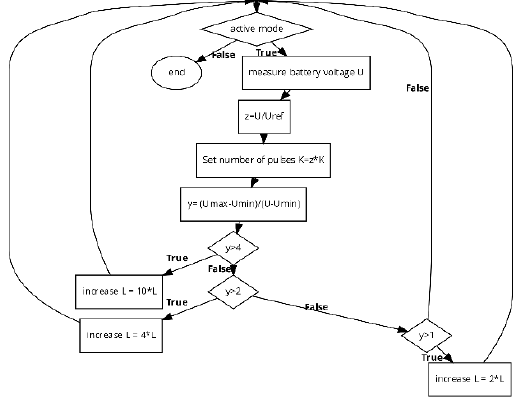
Fig. 4. Algorithm for adjusting signal parameters according to the battery level.